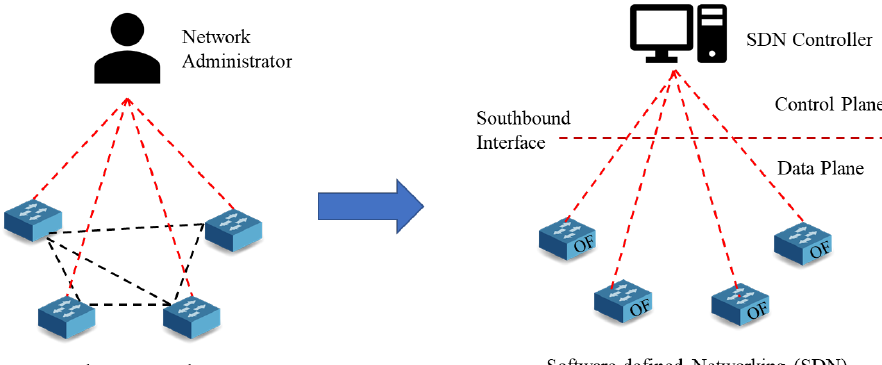
Figure 4. Contemporary network and